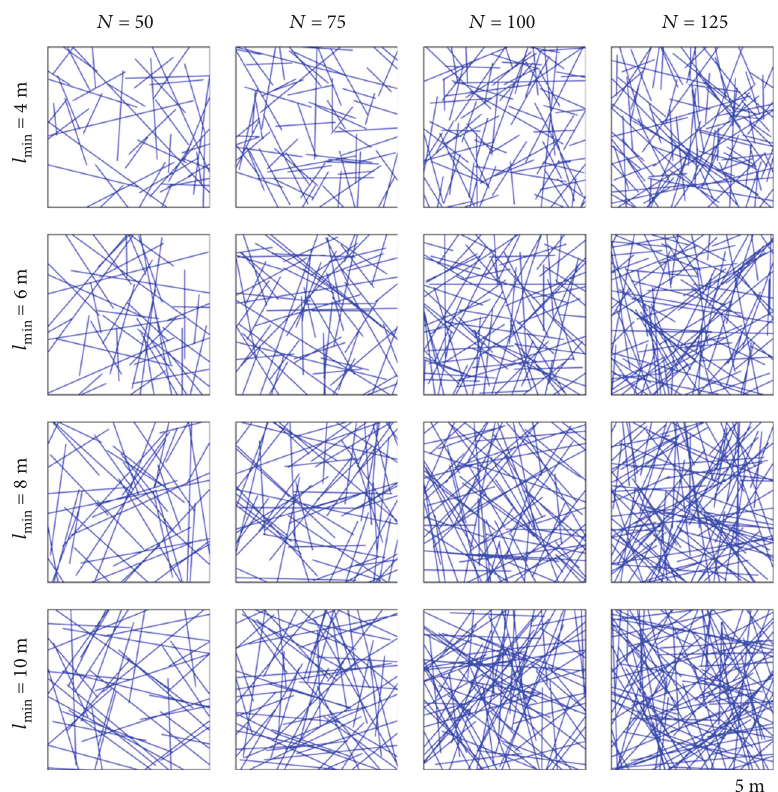
Figure 1: Fracture network geometry with di ff erent geometric